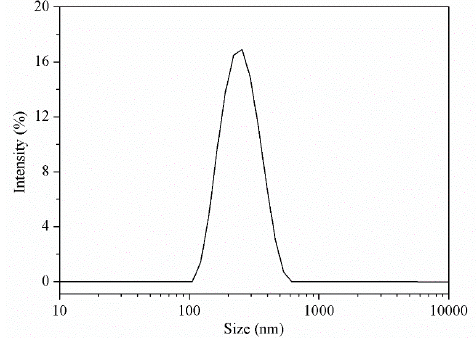
Figure 3. DLS plots of polymersomes.